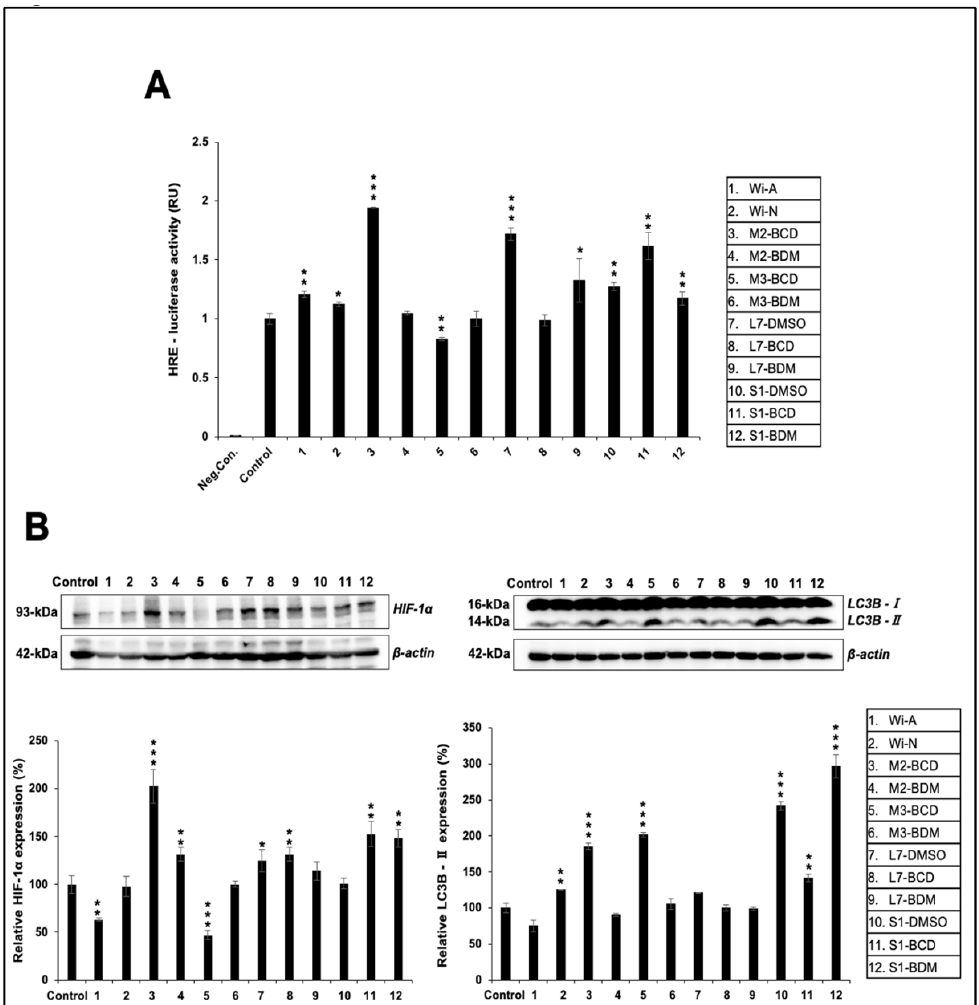
Figure 7. Effect of Ashwagandha extracts and purified withanolides on hypoxia and autophagy. ( A ) HRE-promoter-driven luciferase assay in control and treated cells. ( B ) Western blotting analysis for HIF-1 α and LC3B proteins after treatment with Ashwagandha withanolides. Quantitation of the results is shown below (mean ± SD, n = 3), * p < 0.05, ** p < 0.01, *** p < 0.001 (Student’s t -test to